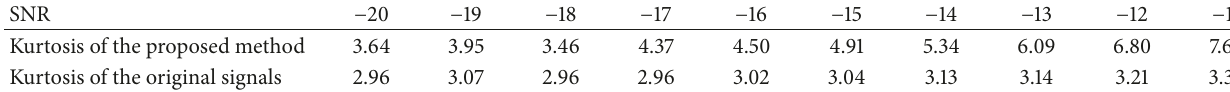
Table 1: The kurtosis values of the proposed method and the original signals.